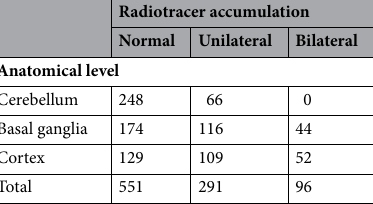
Table 1. Number of slices for patterns of radiotracer accumulation and slice levels in the training